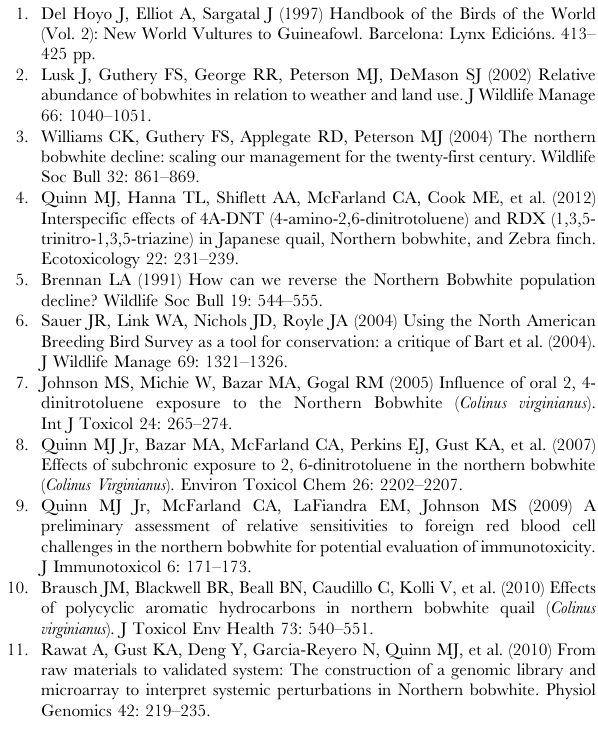
Table S13 NB1.0 Simple de novo Assembly Stats. Table S14 NB1.1 Scaffolded de novo Assembly